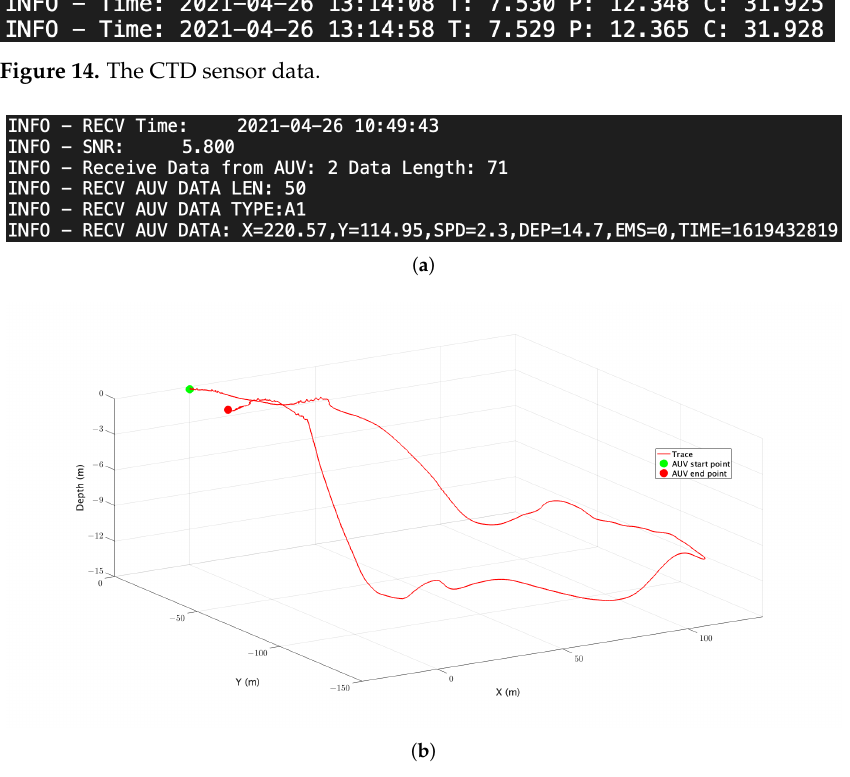
Figure 15. The AUV navigation data. ( a ) the AUV navigation data received by the Surface Gateway Node. ( b ) navigation trajectory plotted from the received data.